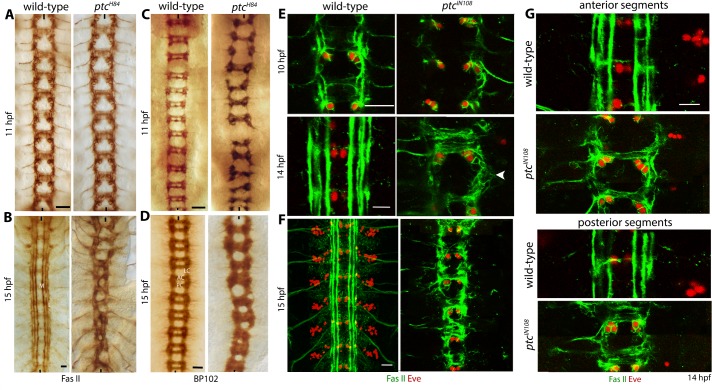
Axon tracts of the ventral nerve cord in ptc mutant embryos progressively narrow with age in an anterior-posterior direction.(A-D): Wild-type and ptc mutant embryos aged 10 and 15 hours of development were stained with Fas II (A, B) and BP102 (C, D) and analyzed with diamino benzidine (DAB) staining. Fas II stains medial (M), Intermediate (I) and Lateral (L) tracts, which become clearly defined by 15 hours of development. BP102 stains anterior commissure (AC), posterior commissure (PC) and longitudinal connective (LC). LC contains both the longitudinal axons and the portion of commissural axons that crosses the midline. Note the well-defined position of tracts along the nerve cord, parallel to the midline and to each other in wild-type. In older mutant embryos, the tracts progressively shift towards the midline. Scale bar: Panels A and C: 22 μm, panels B and D: 8 μm. (E-F): Wild-type and ptc mutant embryos were double stained with Fas II and Even-skipped (Eve) antibodies and analyzed with confocal microscopy. Eve was used as a position-marker. In panel E, 10 hpf and 14 hpf wild-type and ptc embryos are shown. While the newly formed individual tracts are well-defined in 10 hpf embryos, the tracts are defasciculated in 14 hpf ptc mutant embryos (arrow head). In pane F, 15 hpf embryos are shown. By 15 hours of development, the tracts in ptc show the funneling phenotype. In ptc mutant embryos axons inappropriately cross the midline, but this defect is related to the misspecification of neuronal identity [20]. Scale bar: Panel E: 20 μm (upper images) and 8 μm (lower images), and Panel F: 8 μm. (G): Defasciculation in the anterior segments is less severe compared to the posterior segments in ptc embryos. Wild-type and ptc mutant embryos were double-stained for Fas II and Eve. In the anterior segments in ptc mutant, the tracts are much better defined compared to the posterior segments. Scale bar: 8 μm. All the images shown are representative from at least N = 3 independent observations unless otherwise stated.